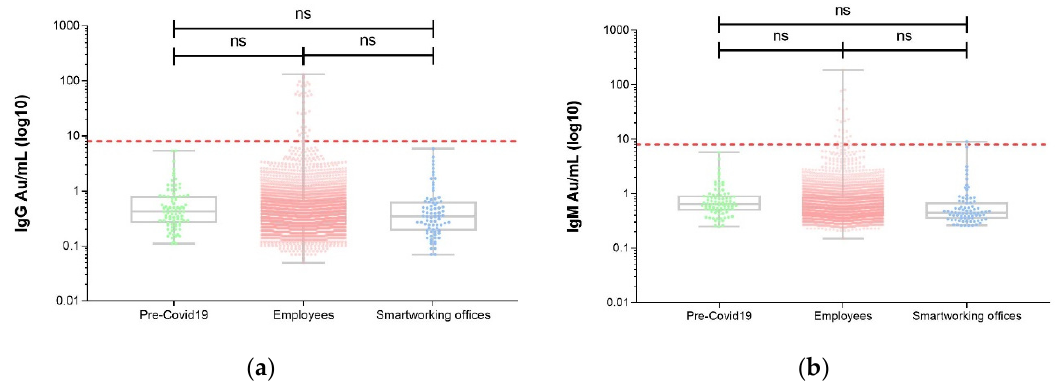
Figure 2. Overall seroprevalence trends at Foggia Hospital “Policlinico Riuniti” during COVID-19